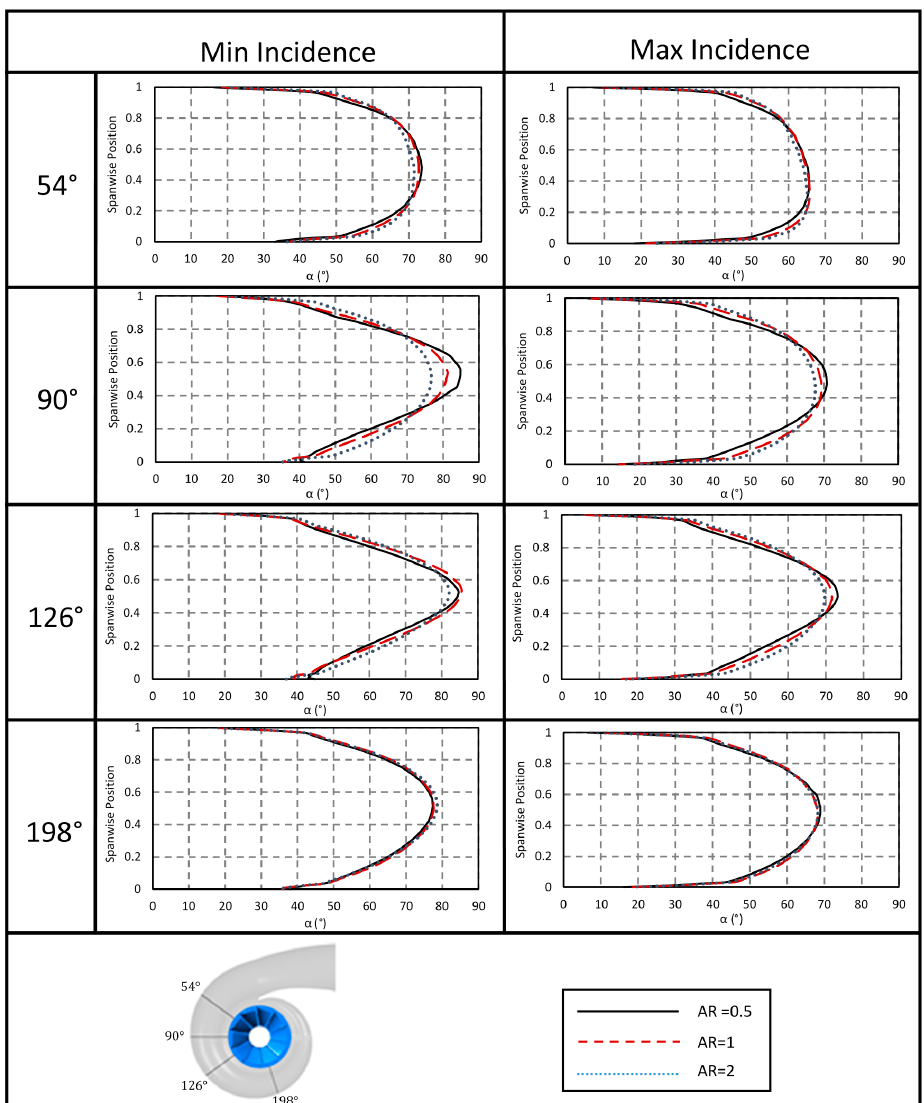
Figure 20. Variation in absolute flow angle across the volute exit span at the minimum and maximum incidence running points.